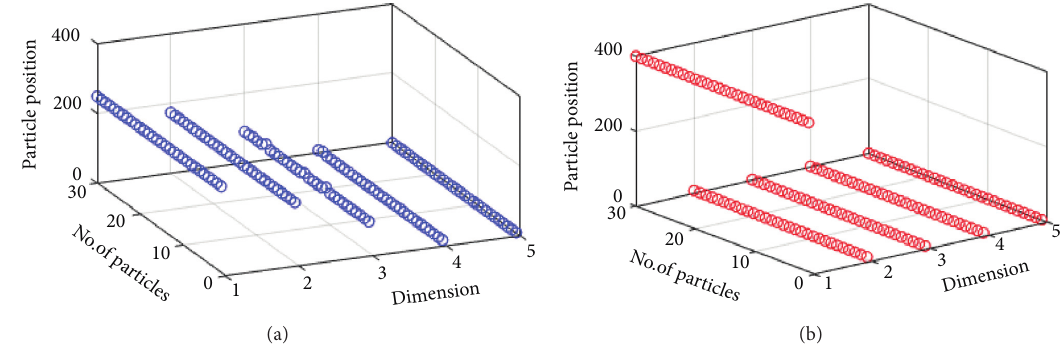
Figure 14: Particle convergence after 400 iterations. (a) PSO. (b) AIWSO.